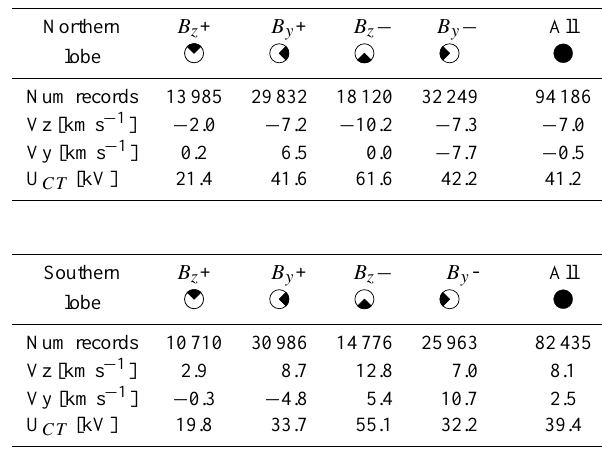
Table 2. Summary of convection velocities, Vz, Vy, and the cross tail potential, U CT for various IMF directions. The rightmost col- umn shows the corresponding average of the full data set without any IMF